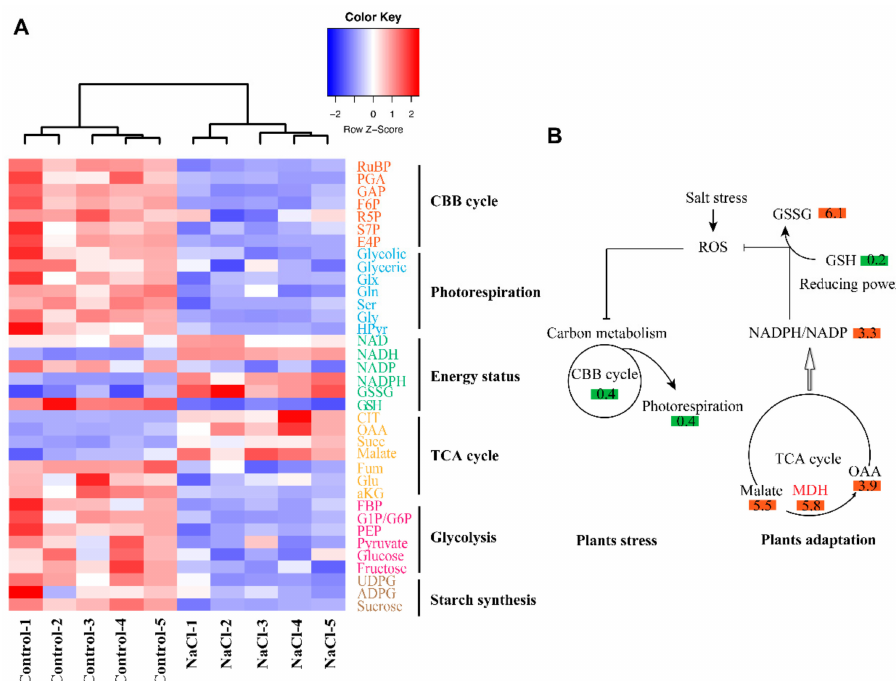
Figure 8. Metabolic reprogramming in alfalfa in response to salt stress. ( A ) Hierarchical clustering heatmap represents the metabolites related to di ff erent metabolic pathways in alfalfa seedlings enduring 200 mM NaCl for 14 d. The heatmap based on the identified protein abundance levels was created using Gene Cluster 3.0 software with the Euclidean distance similarity metric and linkage method. The resulting clusters were visualized using Java TreeView software. ( B ) A proposed model displays the triggering of ROS scavenging in alfalfa plants ascribed to the NADPH reducing power generated following conversion of malate to OAA (Oxaloacetate) in the TCA cycle as an adaptation strategy to salt stress. The numbers displayed in the boxes represent the ratio of metabolites under salt stress against control conditions (Salt / Ctrl), while green and red boxes represent down- and up-regulation of metabolic response in alfalfa to salt stress,